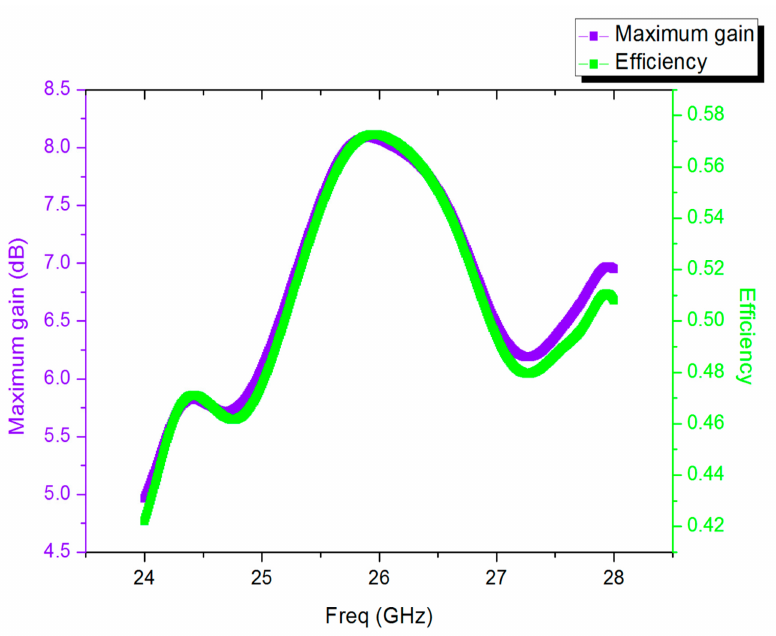
Figure 15. The change curves of gain and efficiency with